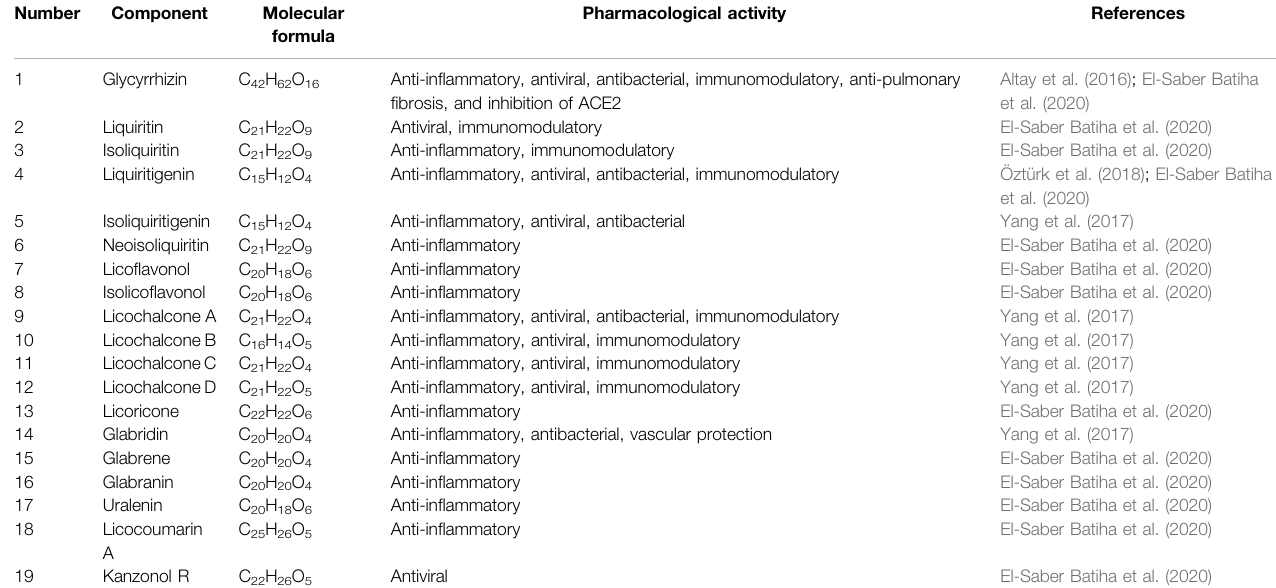
TABLE 1 | The potential components of licorice.